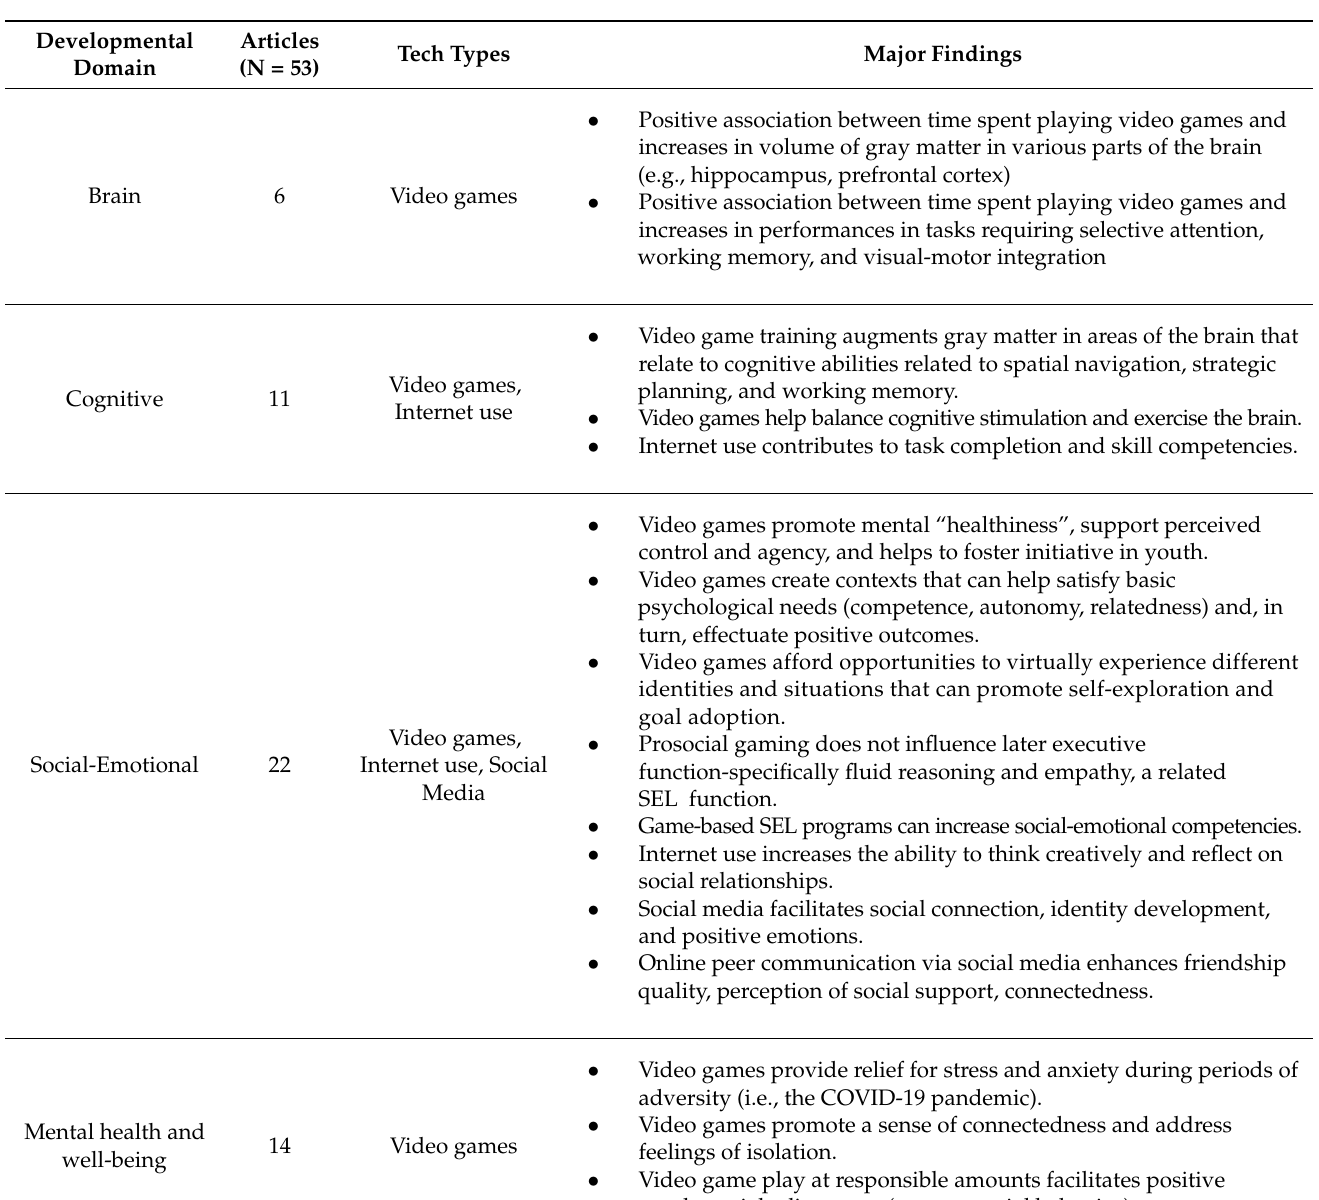
Table 1. Overview of Selected